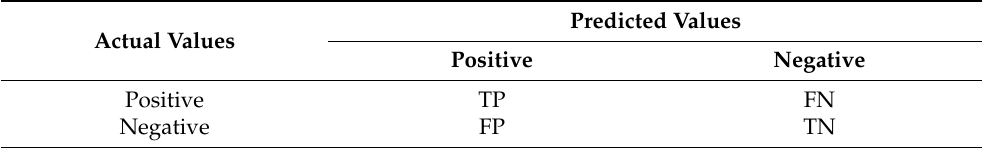
Table 1. Confusion matrix of classification